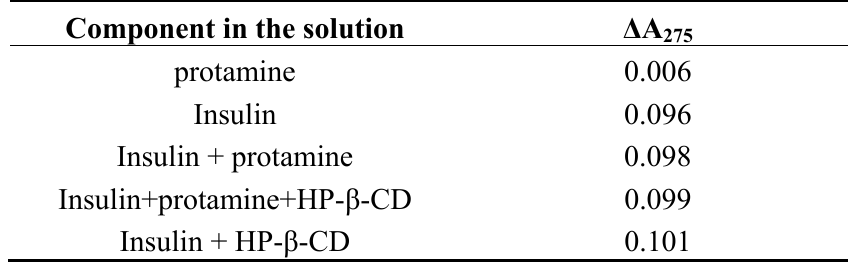
Table 2. The absorption of insulin and